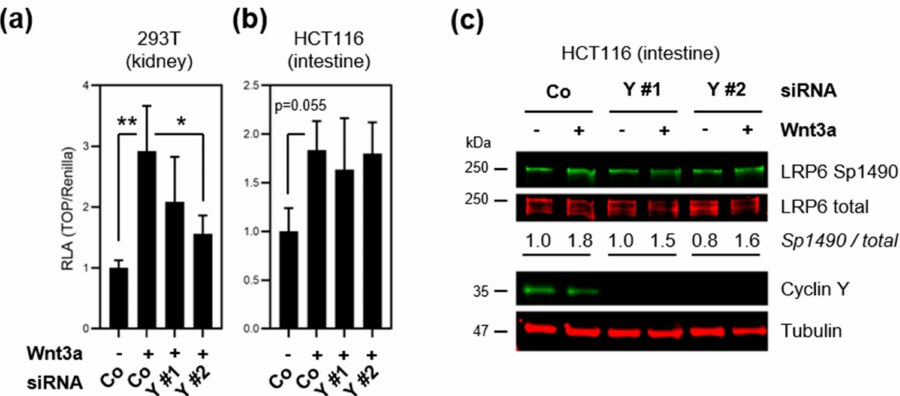
Figure 3. CCNY depletion does not affect Wnt signaling in intestinal epithelial cells. ( a , b ) Wnt activity upon cyclin Y loss-of-function by RNA interference with two siRNAs (Y #1/2) was assessed using the TOPflash luciferase reporter assay in 293T ( a ) and HCT116 cells ( b ). Where indicated, cells were treated with Wnt3a conditioned media. Data were analyzed by Dunnett’s post hoc test following one-way ANOVA, and statistically significant results are indicated as * p < 0.05 and ** p < 0.01 (versus siCo–Wnt3a). ( c ) Immunoblot analysis of active LRP6 (Sp1490) following cyclin Y loss-of-function and Wnt stimulation. The ratio of Sp1490 versus total LRP6 was normalized to the untreated